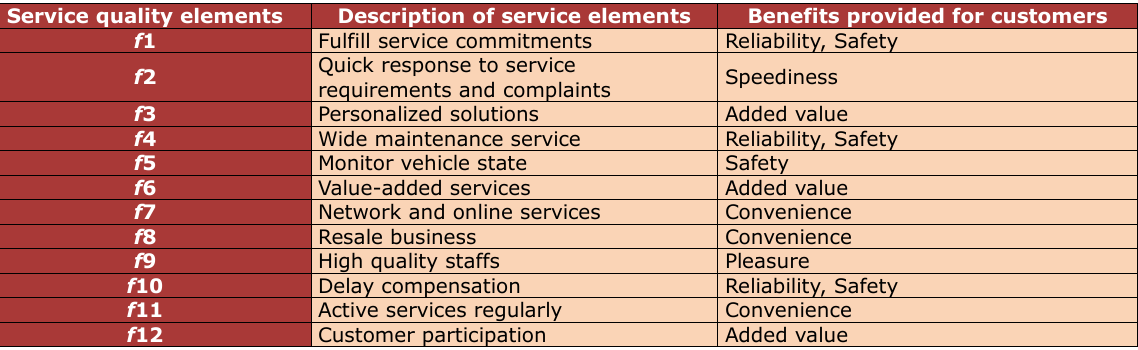
Table 4. Service quality elements in XCMG